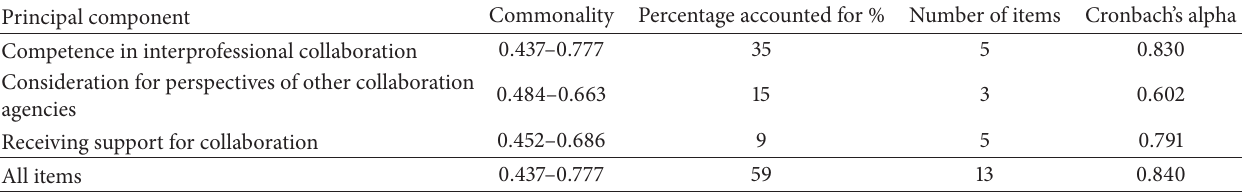
Table 1: Competence in interprofessional collaboration, consideration for the perspectives of other agencies, and receiving support for collaboration: commonalities and percentages accounted for by the principal components, and the internal consistency of the scale as assessed by Cronbach’s alpha ( 𝑛 = 865